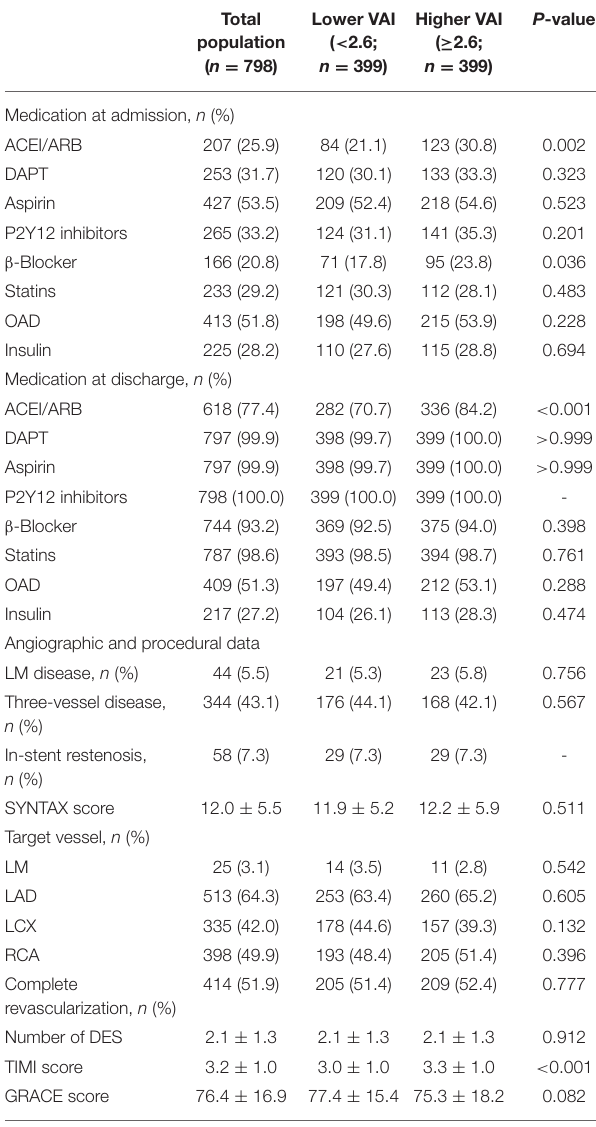
TABLE 1 | Baseline demographic, clinical, and laboratory characteristics of the study population.